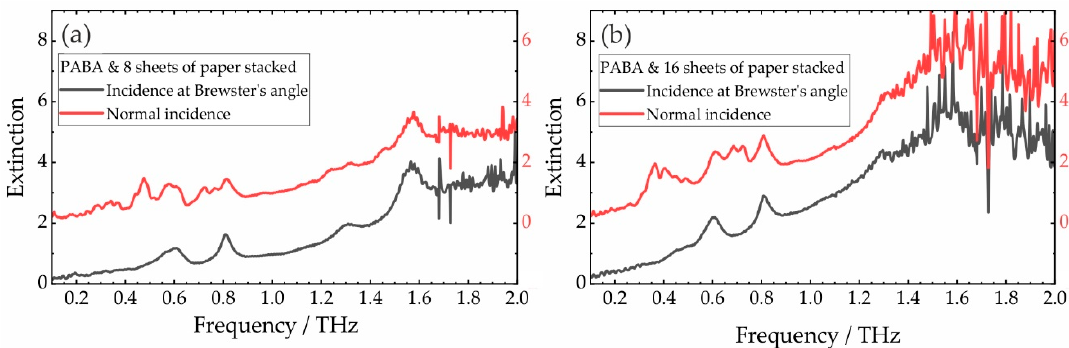
Figure 9. Comparison of the obtained spectra of a PABA sample enclosed in eight sheets of paper ( a ) and 16 sheets of paper ( b ) under normal incidence (red curves) and incidence at the Brewster’s angle (black curves). The spectral quality is greatly enhanced due to the suppression of multiple reflections. The used paper was standard office paper with 80 g/m². Spectra are vertically shifted for better readability.